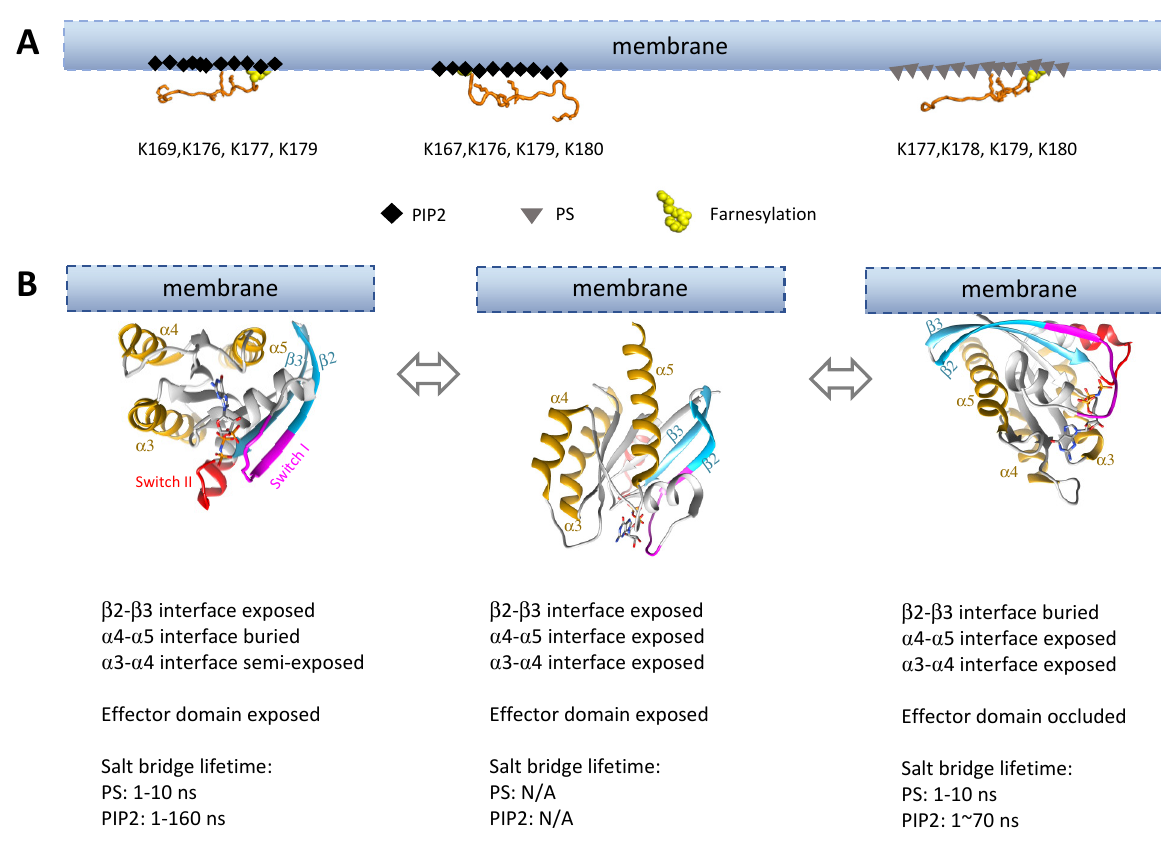
Figure 5. Membrane interactions dictate Ras orientations on the membrane, thus impacting accessibility of the dimer interfaces. ( A ) Interaction of KRas HVRs with different lipid moieties on the membrane. Two different HVR binding modes to the PIP2-enriched (black diamonds) membrane were observed, while one HVR binding mode was identified for PS-enriched (gray triangles) membrane [146,147]. Lysine residues playing an important role in those interactions are shown with stick representation, and the residue numbers are listed below the HVR structures. ( B ) Subset of possible conformations sampled by the G-domain on anionic (PIP2 or PS) membranes. All G-domain orientations were rendered to approximation based on literature [144–146,148–150].